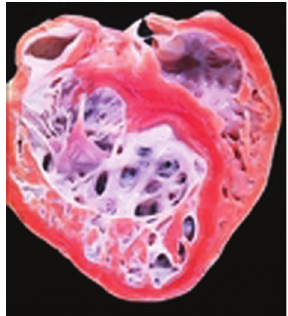
Figure 1 - Gross aspect of the explanted heart, showing the characteristic non-compaction involving the inlet and apical portion of the left ventricle but sparing the ventricular septum.